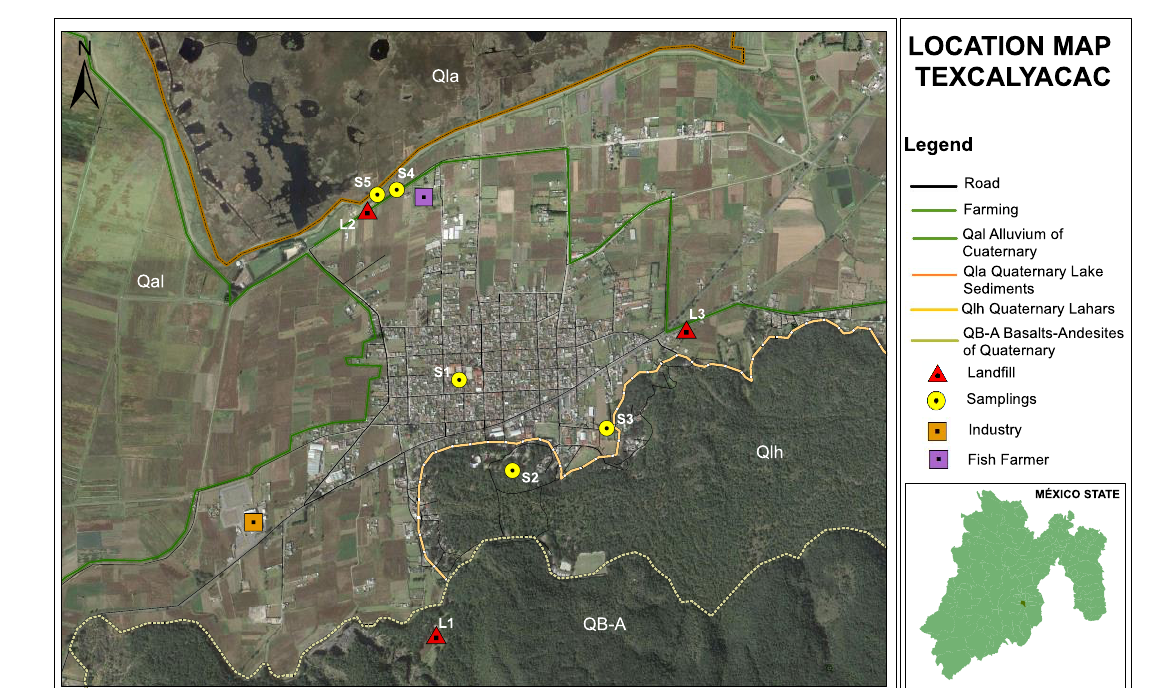
Figure 1. Groundwater sampling locations. Geological context provided.